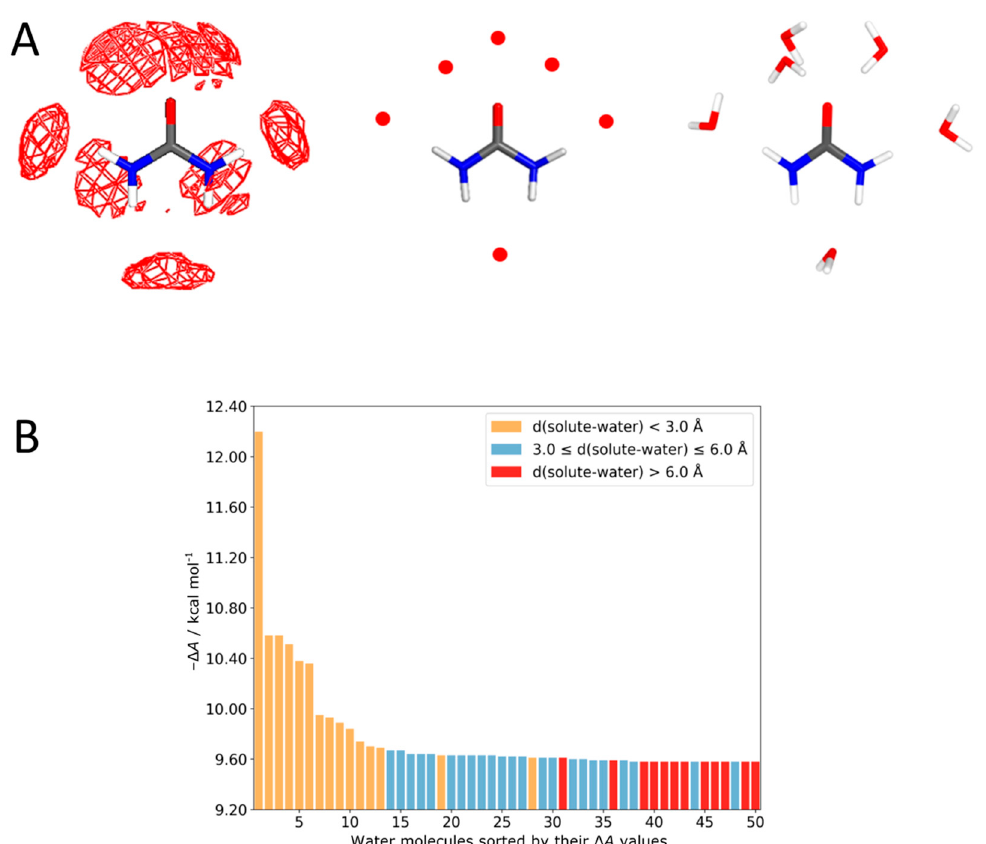
Figure 3. ( A ) Representation of the automated water placement algorithm. Left: Urea’s water density map. Middle: Ascertained water oxygen positions. Right: Final solvated complex with appropriate water hydrogen orientations. ( B ) Ranking of the automatically placed water molecules around the urea molecule. The free energy of the first 50 water molecules is depicted. The distances between solute and water are color-coded, whereby orange denotes a solute–solvent distance of less than 3 Å; blue, a solute–water distance between 3 and 6 Å; and red, a solute–water distance of more than 6 Å. Based on the FEBISS bar chart, we selected three urea–(H 2 O) n complexes, with n corresponding to 1, 6, and 13 water molecules. Both the urea–(H 2 O) n complexes directly